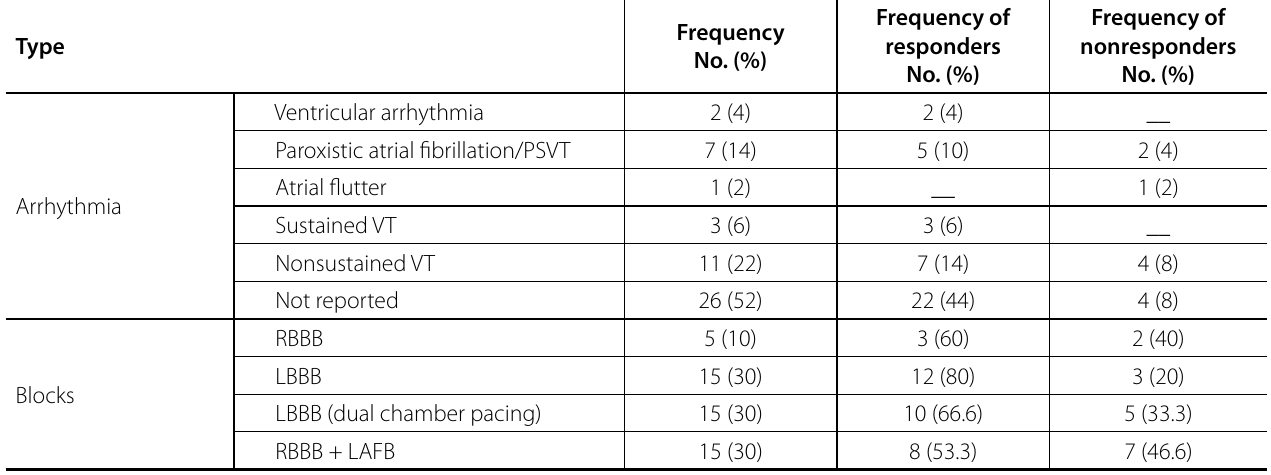
Table 2 . Electrophysiological disturbances of the patients. Type